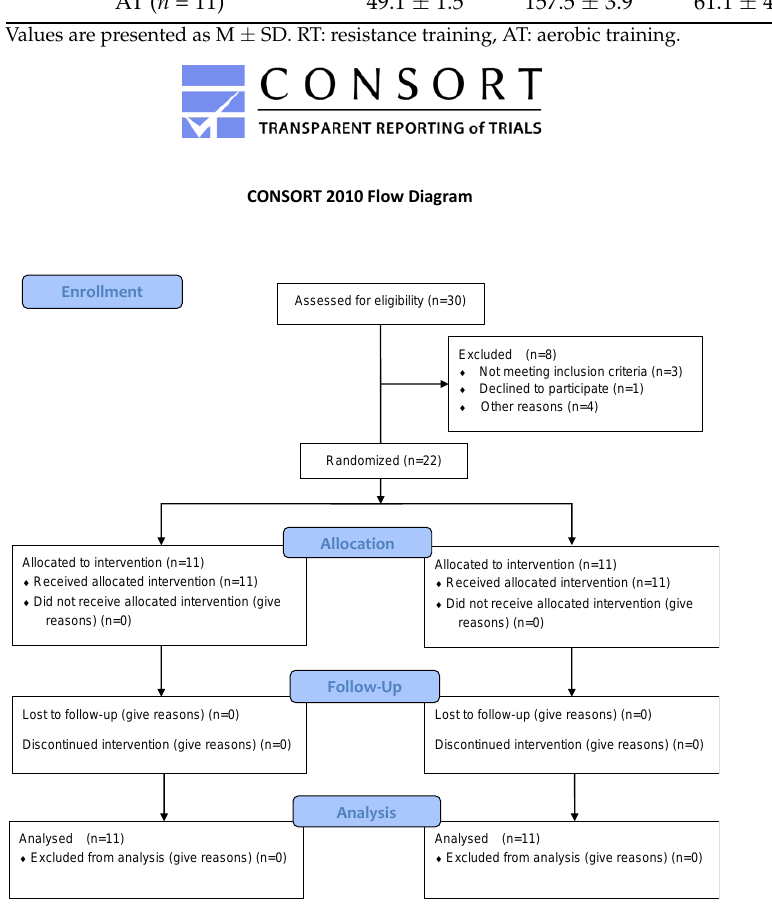
Figure 1. CONSORT flow diagram for the individual randomized, controlled trial.